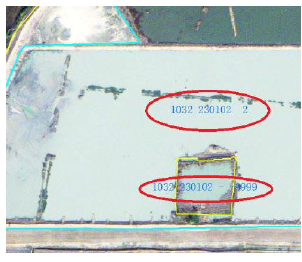
Figure 5. Change type error